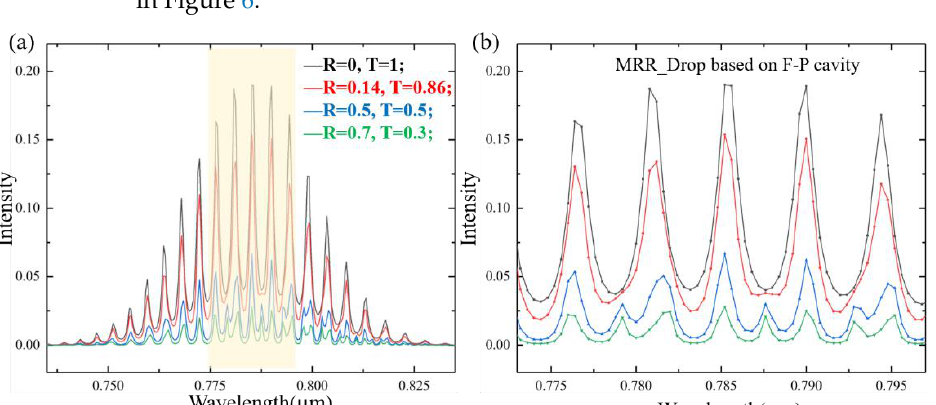
Figure 6. ( a ) Spectral signal of Drop under different reflectivities. R = 0 (black), R = 0.14 (red), R = 0.5 (blue) and R = 0.7 (green). ( b ) Partial enlarged view at resonance wavelength.